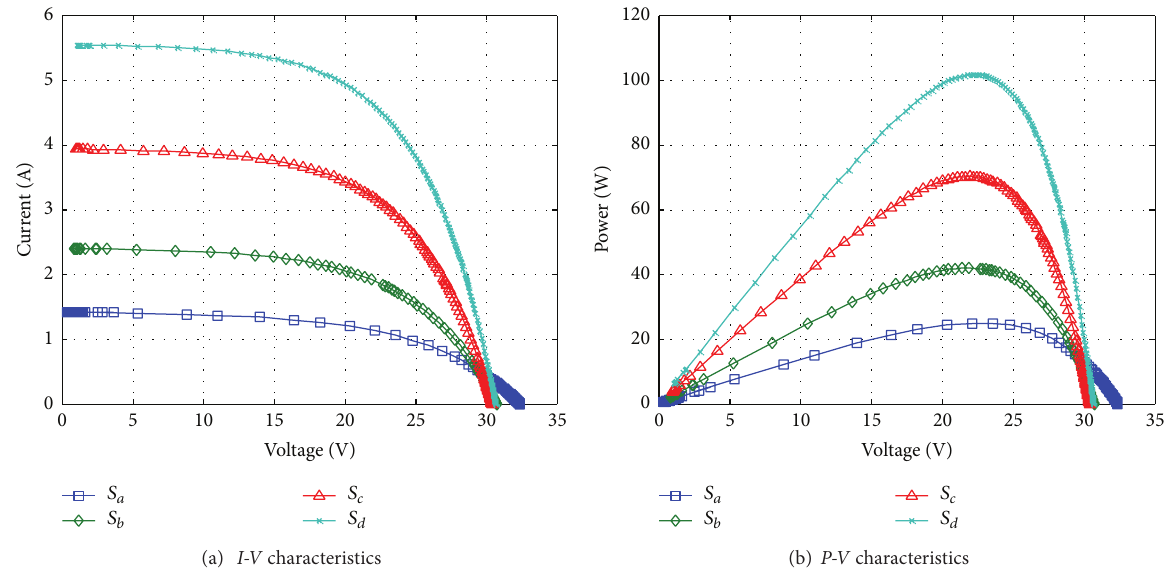
Figure 8: The effect of solar irradiation on I-V and P-V characteristics of the PV array.